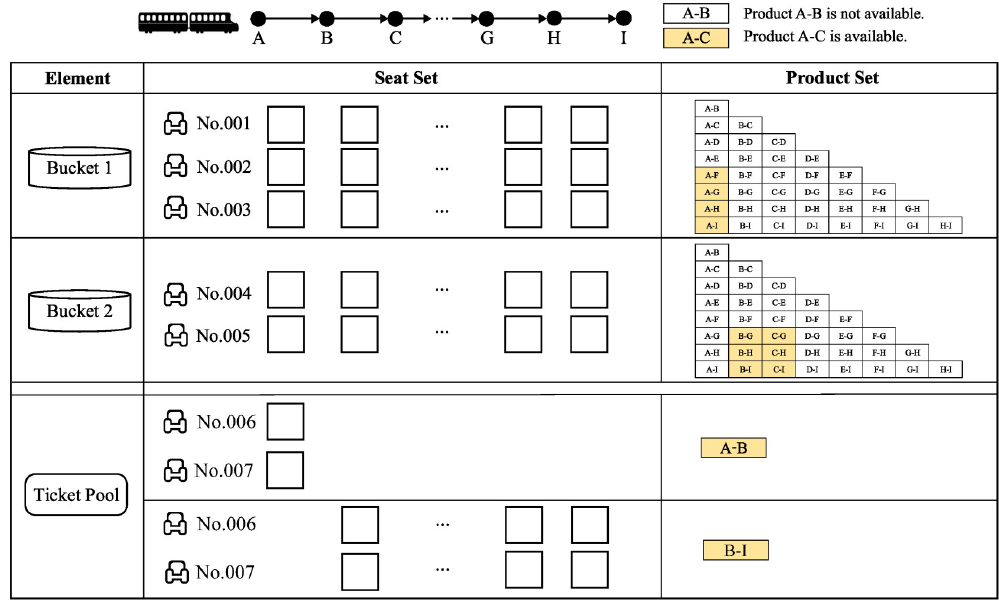
Fig 5. An example of the fundamental